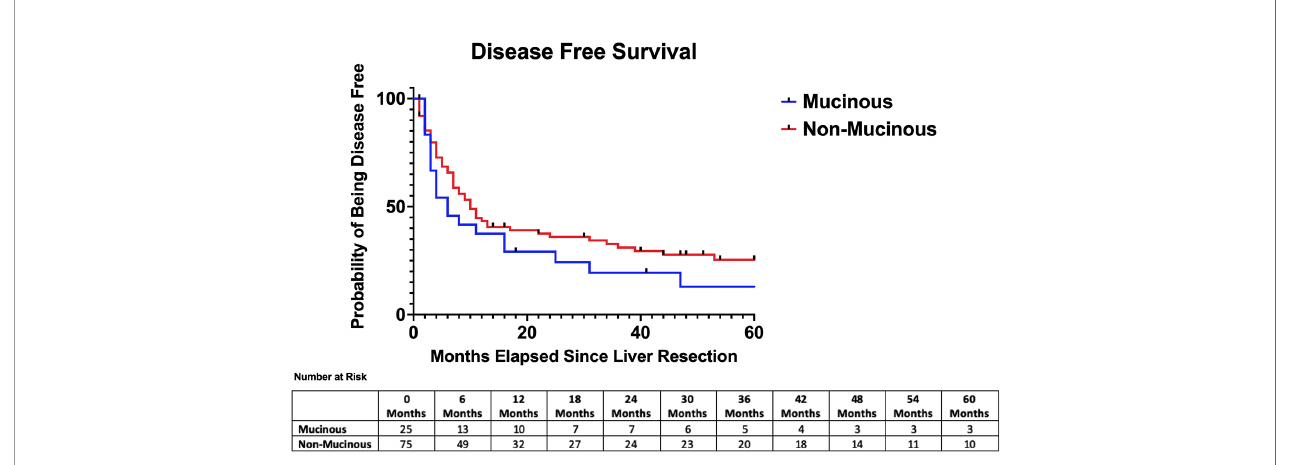
FIGURE 2 | Disease-free survival after hepatic resection. Median disease free survival = 6 months (mucinous) versus 10 months (non-mucinous) p = 0.25.